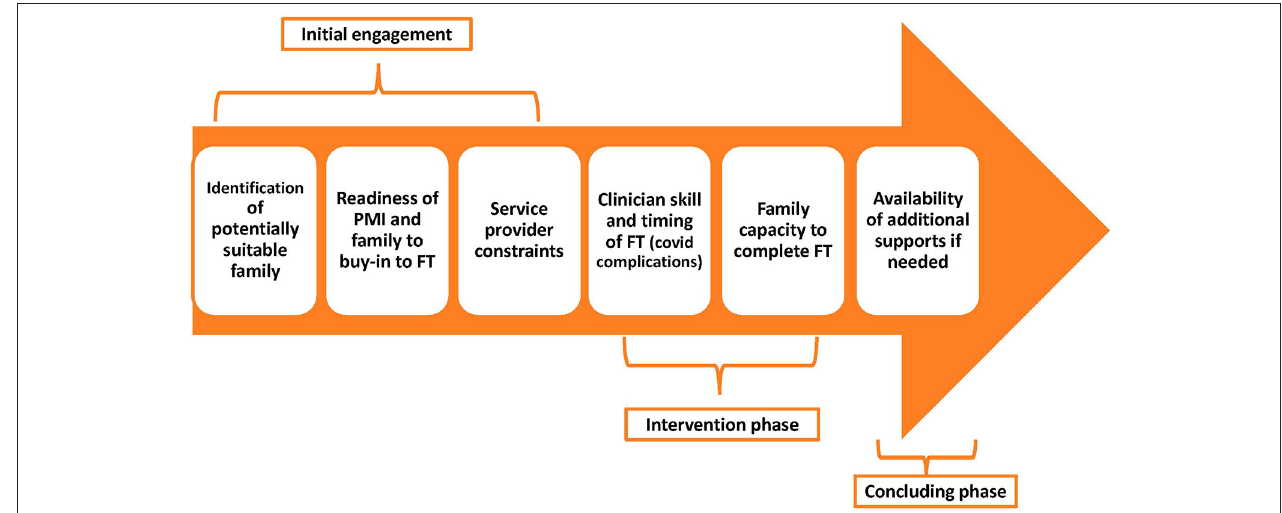
FIGURE 3 | Challenges to participation in Family Talk during the engagement, intervention and ending phases.